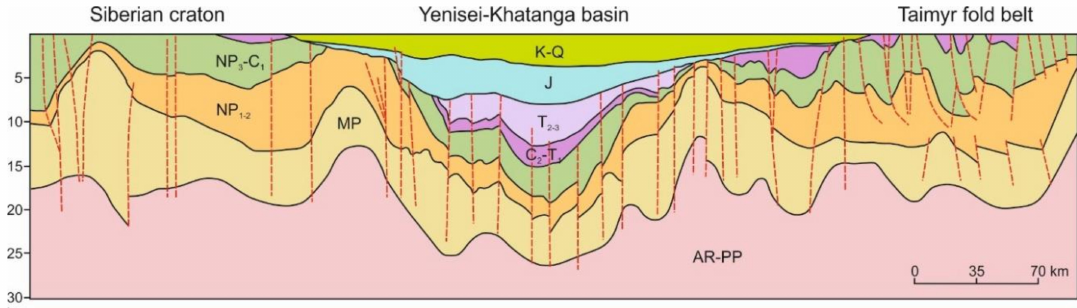
Figure 6. Seismic-geological section along the common depth point traverse line Norilsk–Kara Sea, modified after Reference [22]. The location of the line is shown on Figure